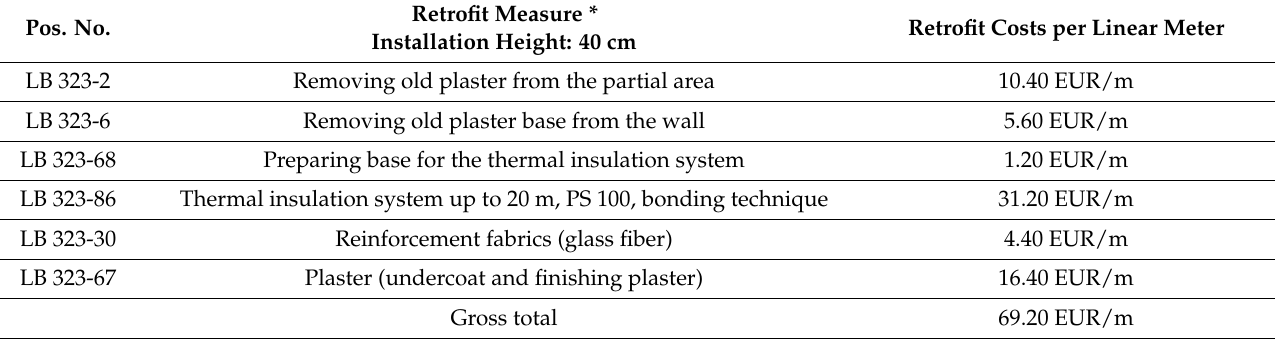
Table A16. Retrofit components and costs of the thermal bridge retrofit of a window reveal [38,39]. Pos. No.